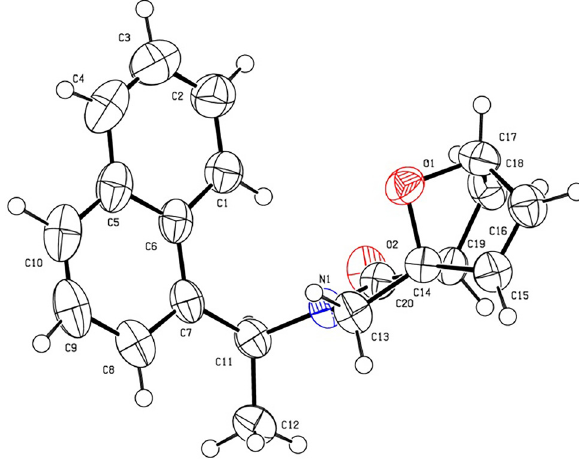
Table  : Data collection and